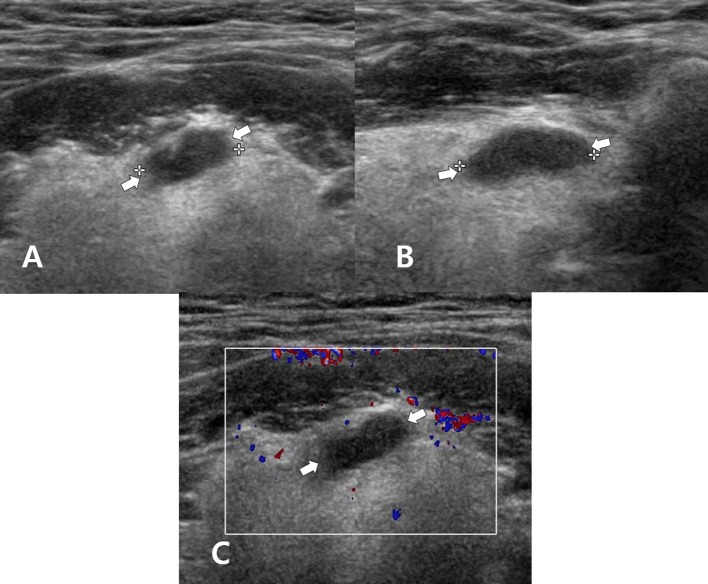
A 60~65-year-old man who underwent total thyroidectomy and one session of radioactive iodine ablation (160 mCi) for papillary thyroid carcinoma. On the follow-up neck ultrasonography (US), transverse gray-scale (A), longitudinal gray-scale (B), and transverse color Doppler (C) US images show a well-defined cystic lesion with a flat-to-ovoid shape in the suprahyoid, anterior upper midline neck (arrows, 1.3 cm in length).